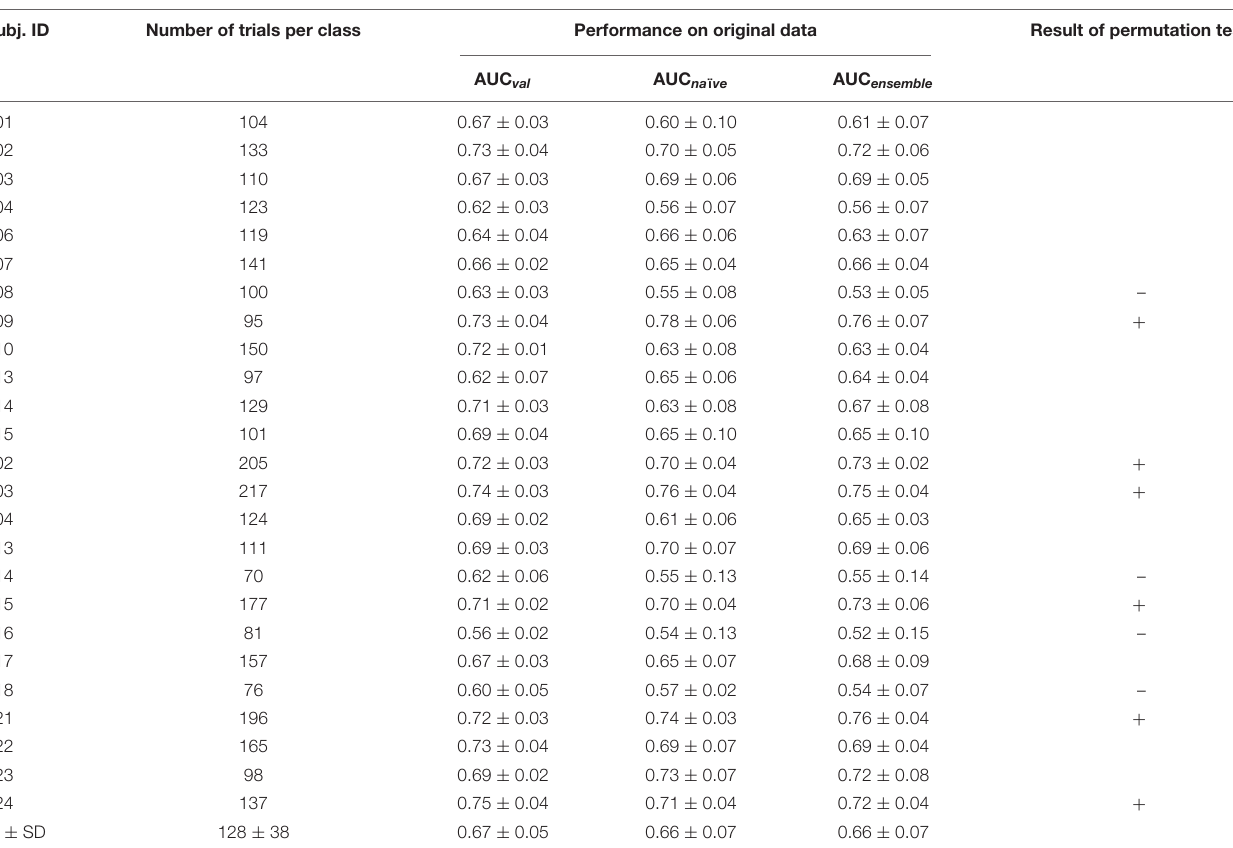
TABLE 1 | Individual classification performance of LF-CNN for 25 participants. Subj.